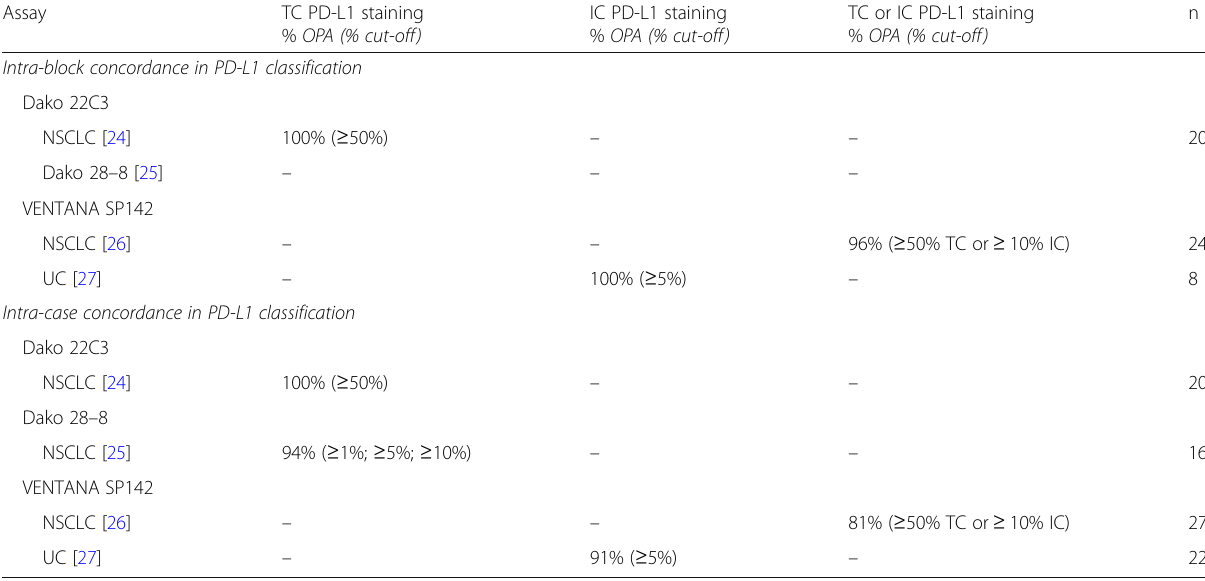
Table 6 Data on intra-block and intra-case concordance in PD-L1 classification, from publicly available FDA documents a Assay TC PD-L1 staining IC PD-L1 staining TC or IC PD-L1 staining % OPA (% cut-off) % OPA (% cut-off) % OPA (%